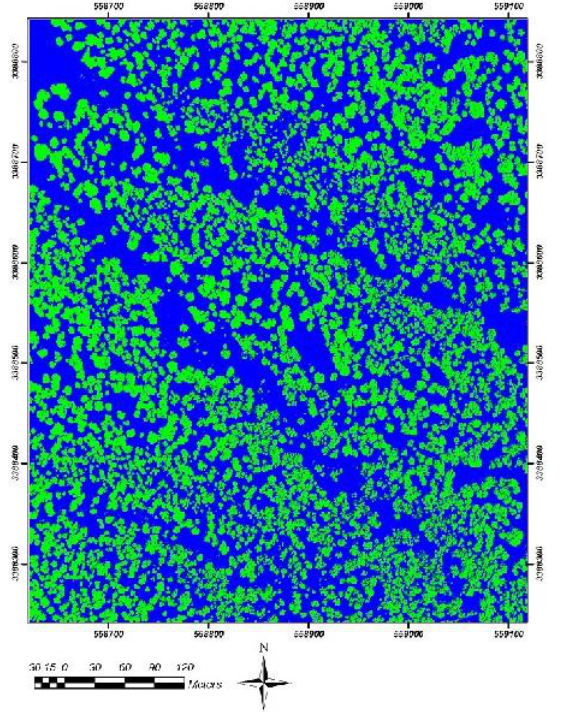
Figure 6: The canopy cover map of the study area.